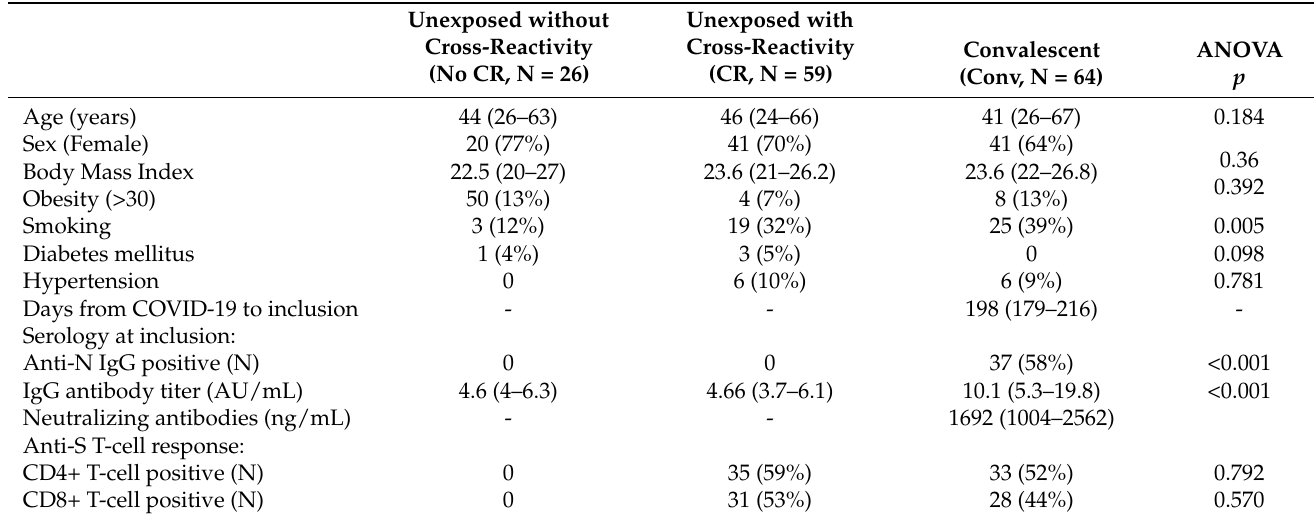
Table 1. Characteristics of the individuals that were included in this